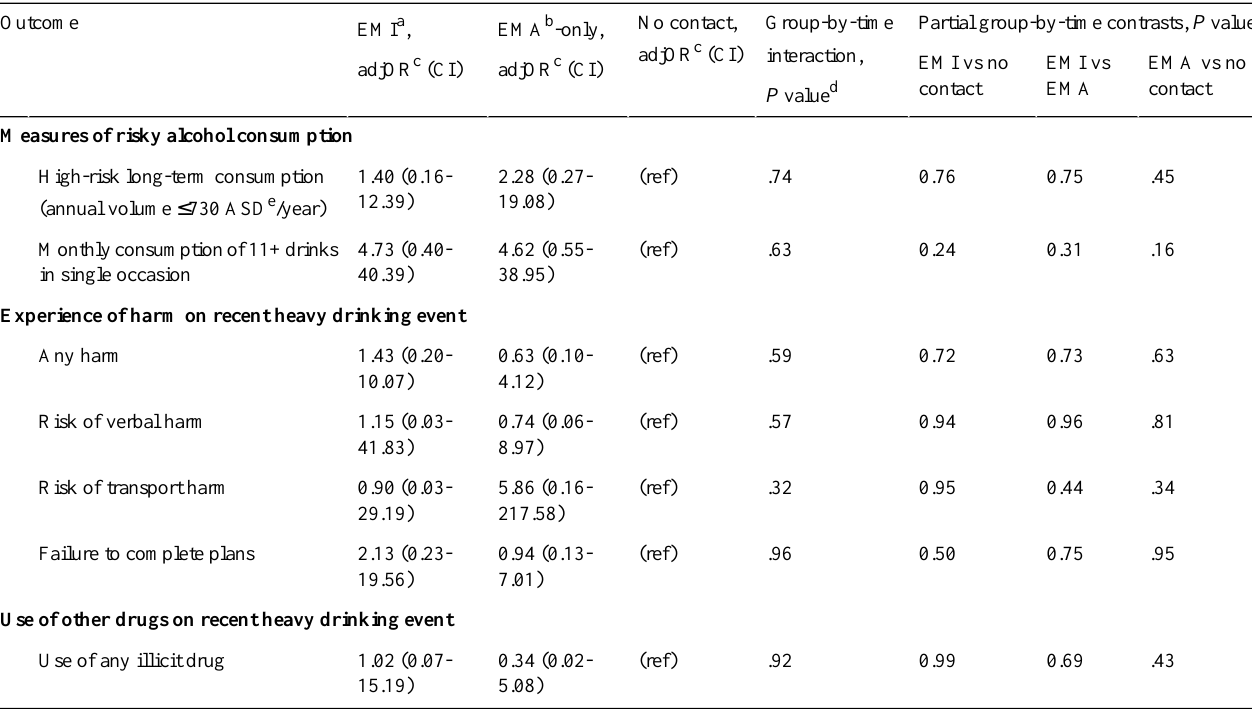
Table 3. Secondary measures of risky alcohol consumption and alcohol-related harms: adjusted odds ratio (adjOR), P values from group-by-time interactions, and partial group-by-time contrasts from generalized linear mixed modeling